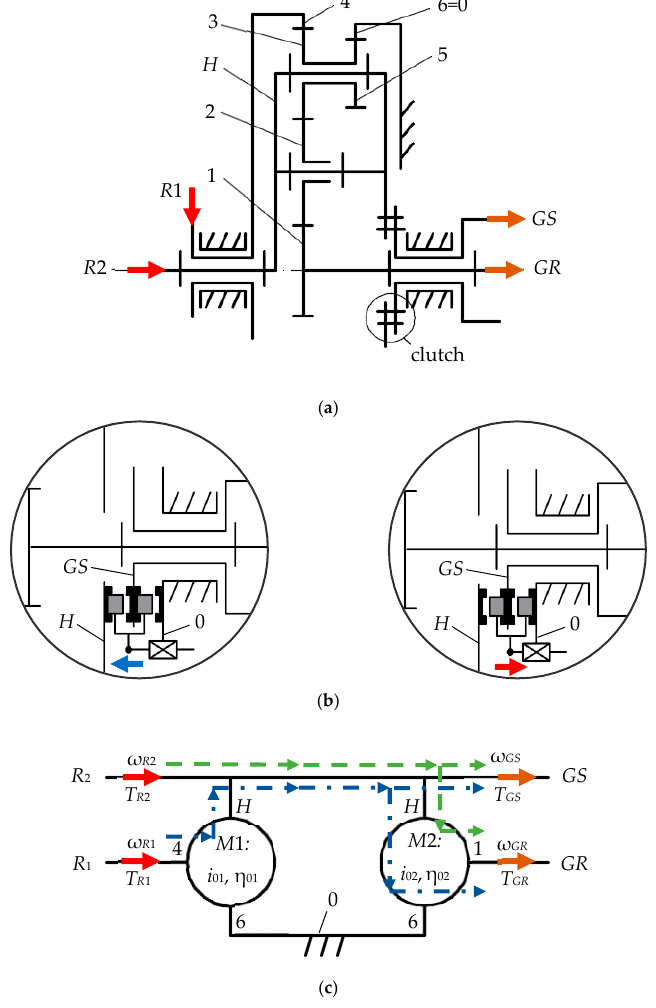
Figure 4. 1-DOF cylindrical-gear speed increaser in a generalized configuration with two inputs and two outputs: (a) structural diagram; (b) detail of the two-way clutch (left) in the H ≡ GS position and (right) in the GS ≡ 0 position; (c) block diagram showing the input-output power flow.